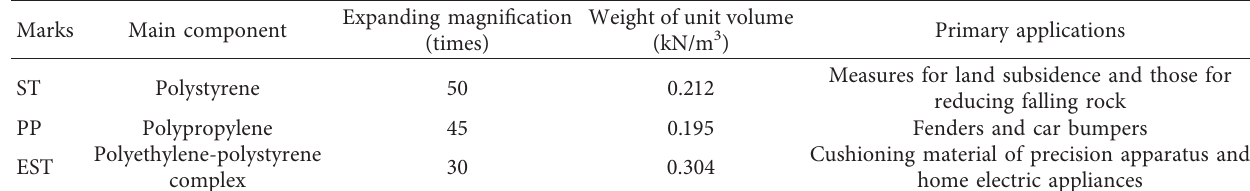
Table 1: Material property of the expanded material.